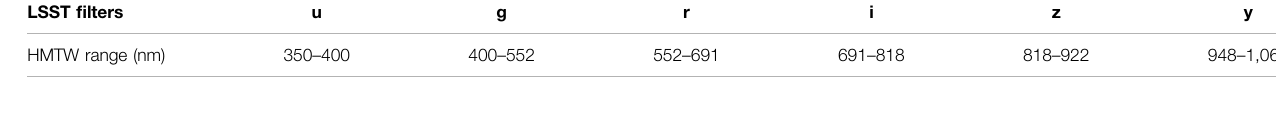
Frontiers in Astronomy and Space Sciences |